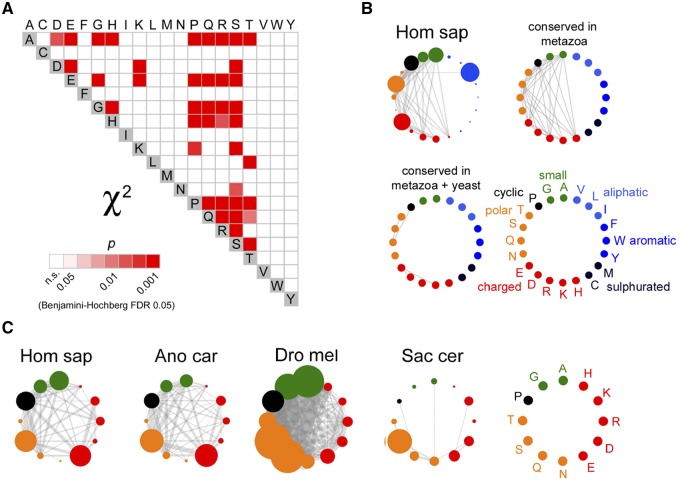
—Nonrandom pairwise combinations of AARs throughout phylogenesis. (A) Grid diagram showing the statistically significant pairwise AAR combinations in the human proteome that is, those combinations whose occurrence exceeds what expected by chance based on the proportions of proteins bearing the two AARs, as determined by the χ2 test (with Benjamini-Hochberg correction, FDR = 0.05). The significance level of each combination is highlighted in shades of red. (B) The upper left graph shows the significant pairwise combinations of AARs in the human proteome as lines connecting nodes that represent the 20 AARs, ordered based on their biochemical features as indicated in the legend (bottom right). The size of each node is proportional to the percentage of proteins containing the corresponding AAR in the proteome (%X4). The upper right graph shows AAR combinations that are significant also in other five metazoan species (B. taurus, Bos tau, A. carolinensis, Ano car, T. rubripes, Tak rub, D. melanogaster, Dro mel, C. elegans, Cae ele; top right graph). Only a few combinations are also conserved in yeast (S. cerevisiae, Sac cer; bottom left). (C) The first graph on the left, is a simplified version of the graph shown in (B) (Hom sap) after removing the AARs of aliphatic/aromatic/sulphurated amino acids (legend on the right). Edge tickness is proportional to the χ2 value for each significant AAR combination. The other graphs represent the significant AAR combinations in the indicated species.